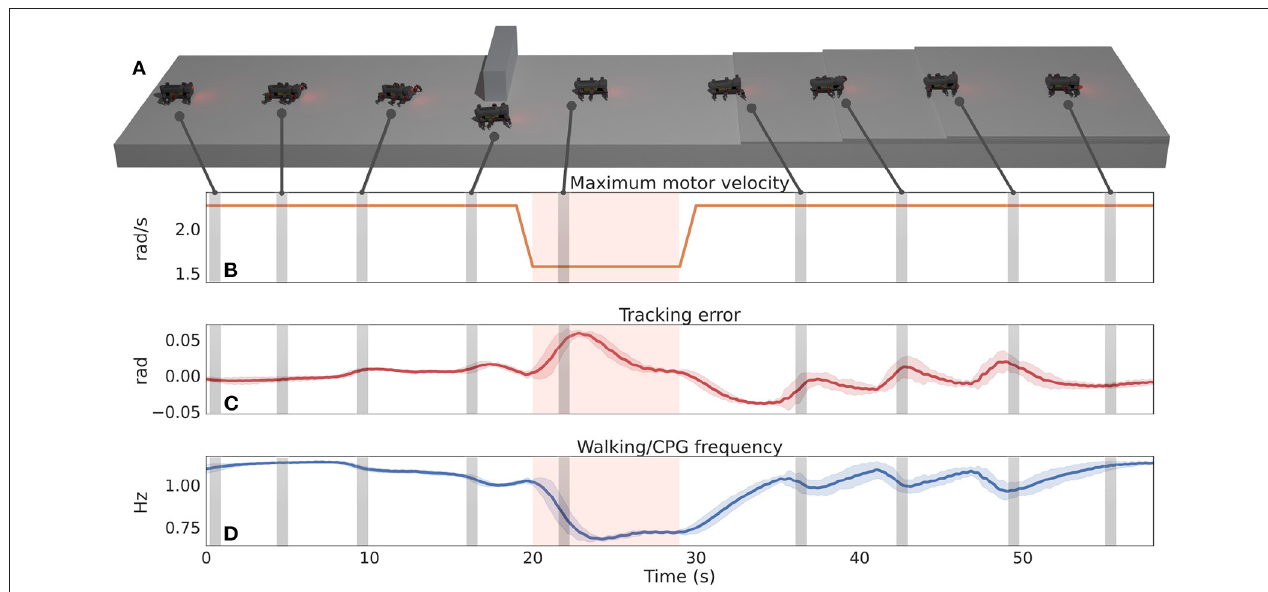
FIGURE 3 | (A) The simulated environment and nine snapshots of MORF when using the locomotion controller with frequency and motor pattern adaptation. Each snapshot is highlighted on the plots below. (B) The motor performance (i.e., maximum velocity), which is lowered by 30 % when MORF has passed the wall until it reaches the first step (red zone on the plots). (C) The mean tracking error. (D) The CPG